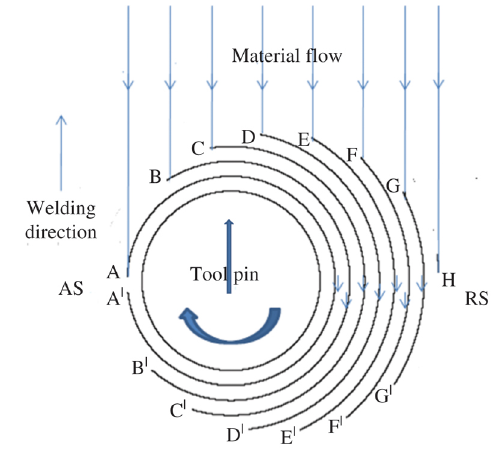
Figure 10: Top view of the tool pin from the shoulder side; angular arrow is the direction of rotation.